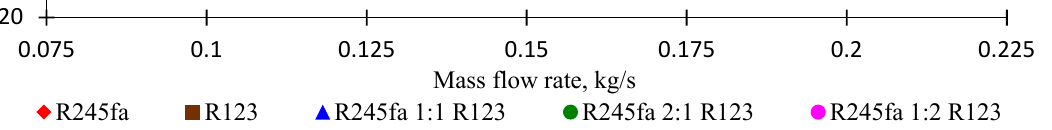
Figure 17. Evaporator heat input as a function mass flow rate for R245fa, R123, and mixed working fluids with heat source at 120 ° C.